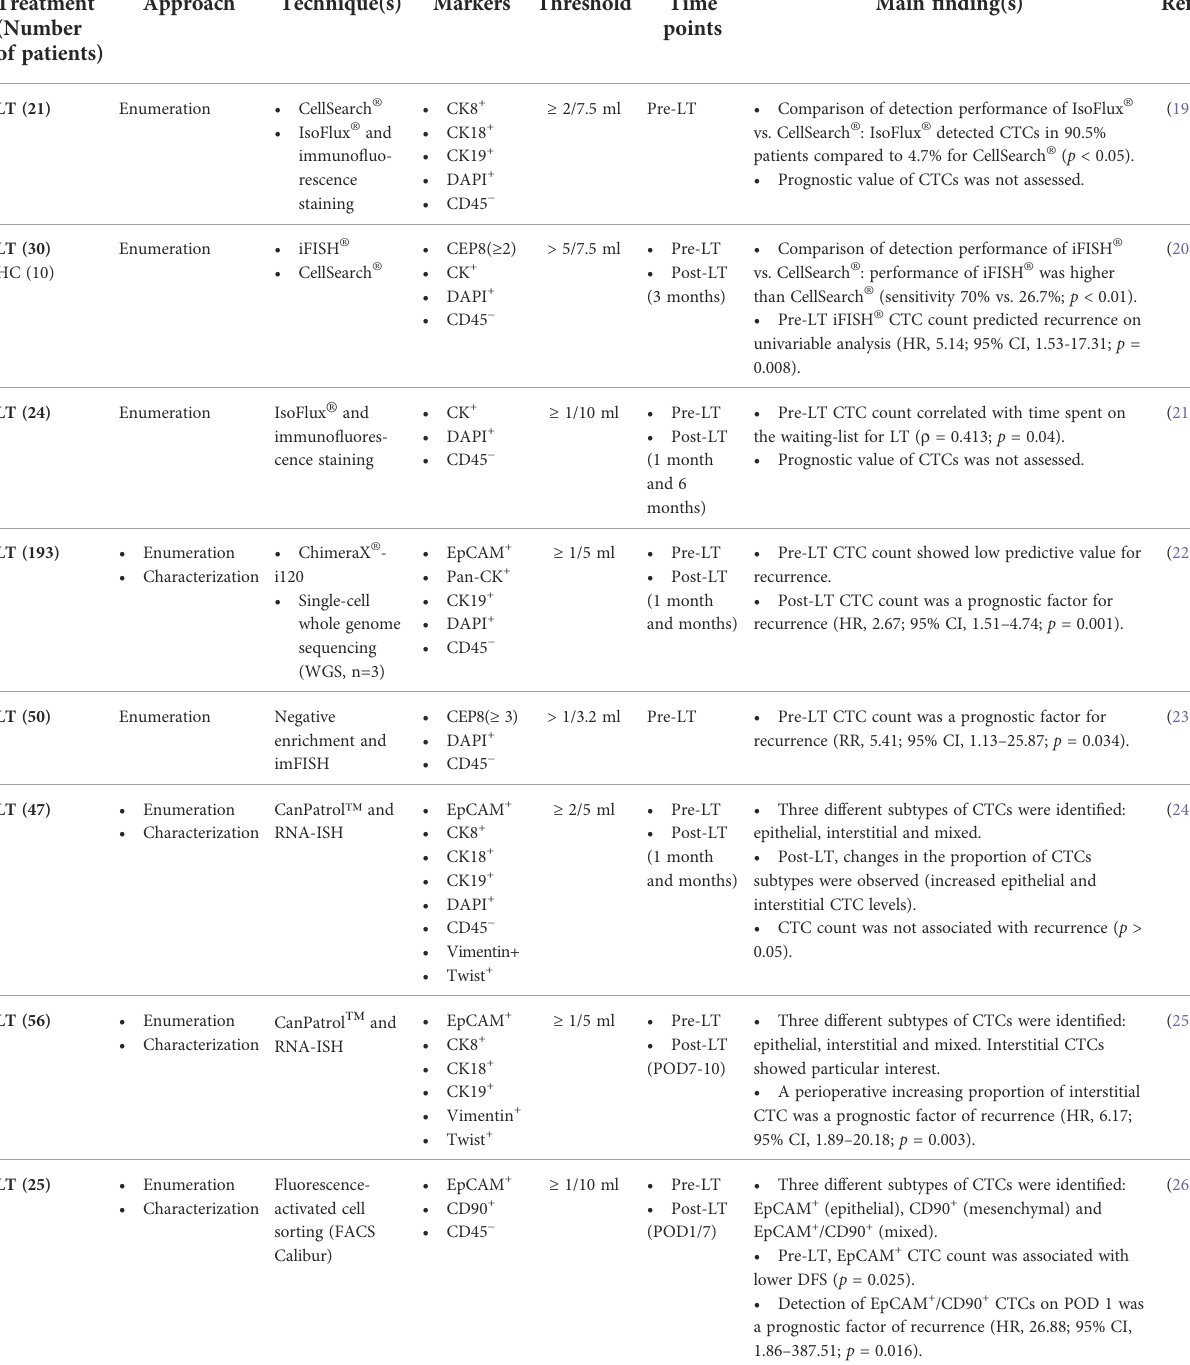
TABLE 1 Circulating tumor cells in liver transplantation for hepatocellular